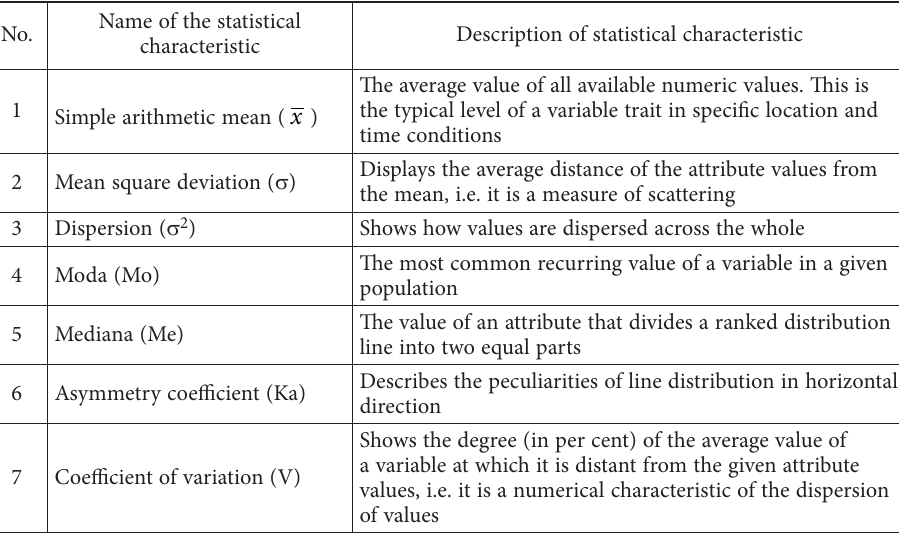
Table 8. Statistical characteristics of analysis of economic development indicators of Polish and Lithu- anian regions (source: compiled by authors)